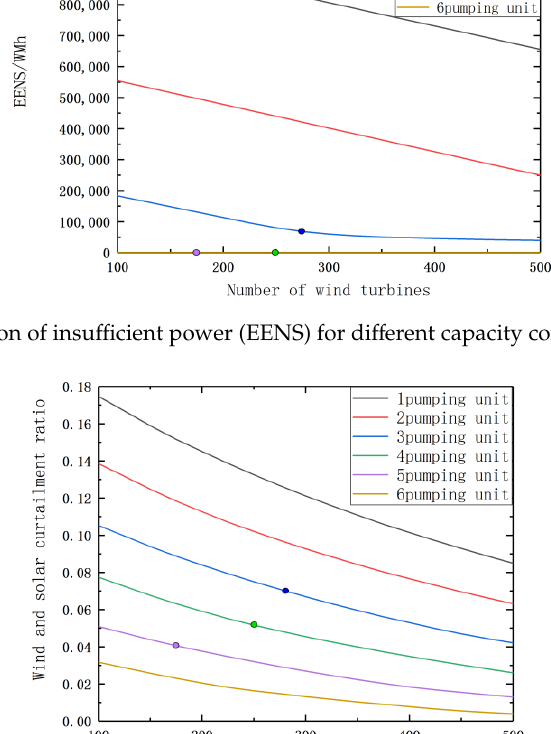
Figure 12. Wind power and solar power curtailment ratio for different capacity configuration schemes. Table 3. Scheme 1, 2, 3 reliability and comprehensive income comparison table.